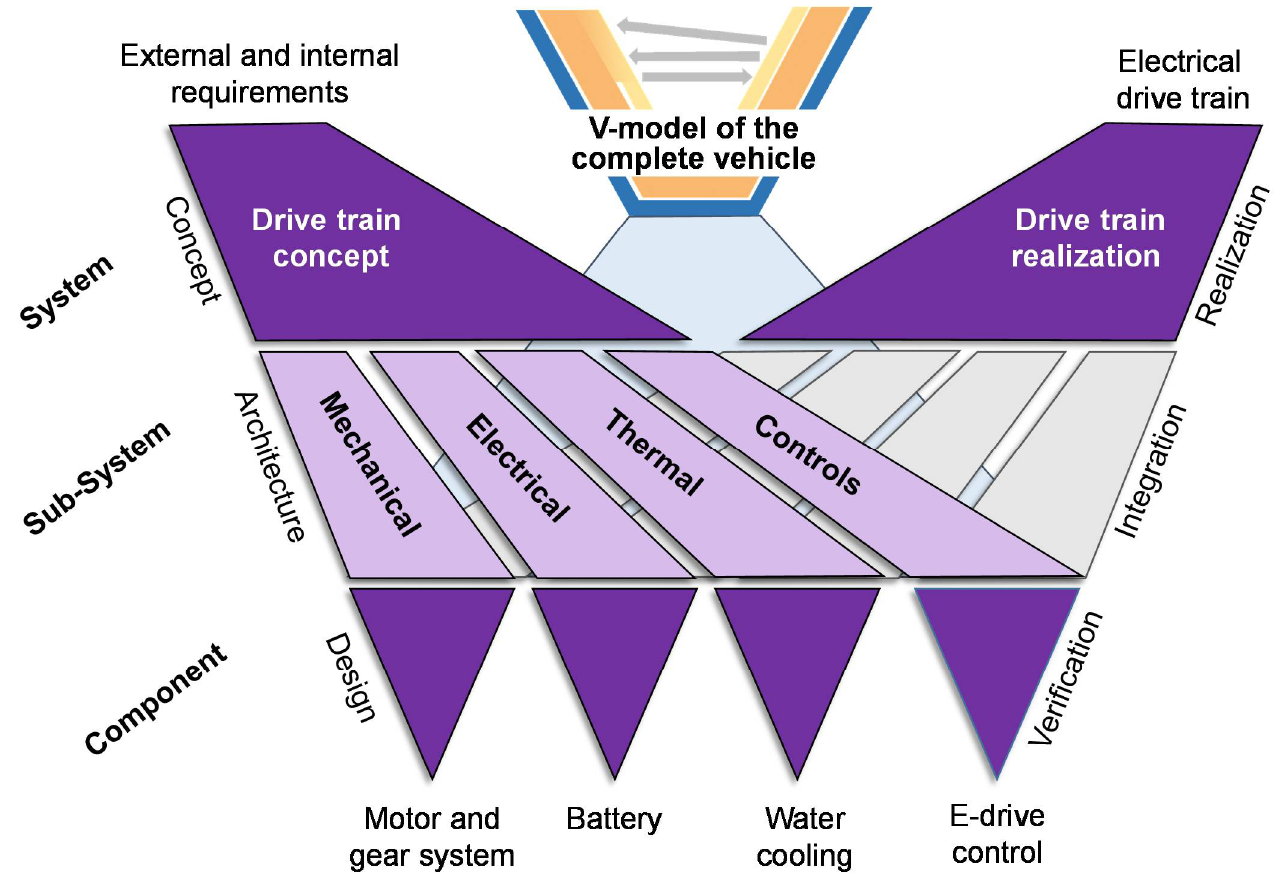
Figure 2. Process overview of design and simulation activities in the drive-train development.